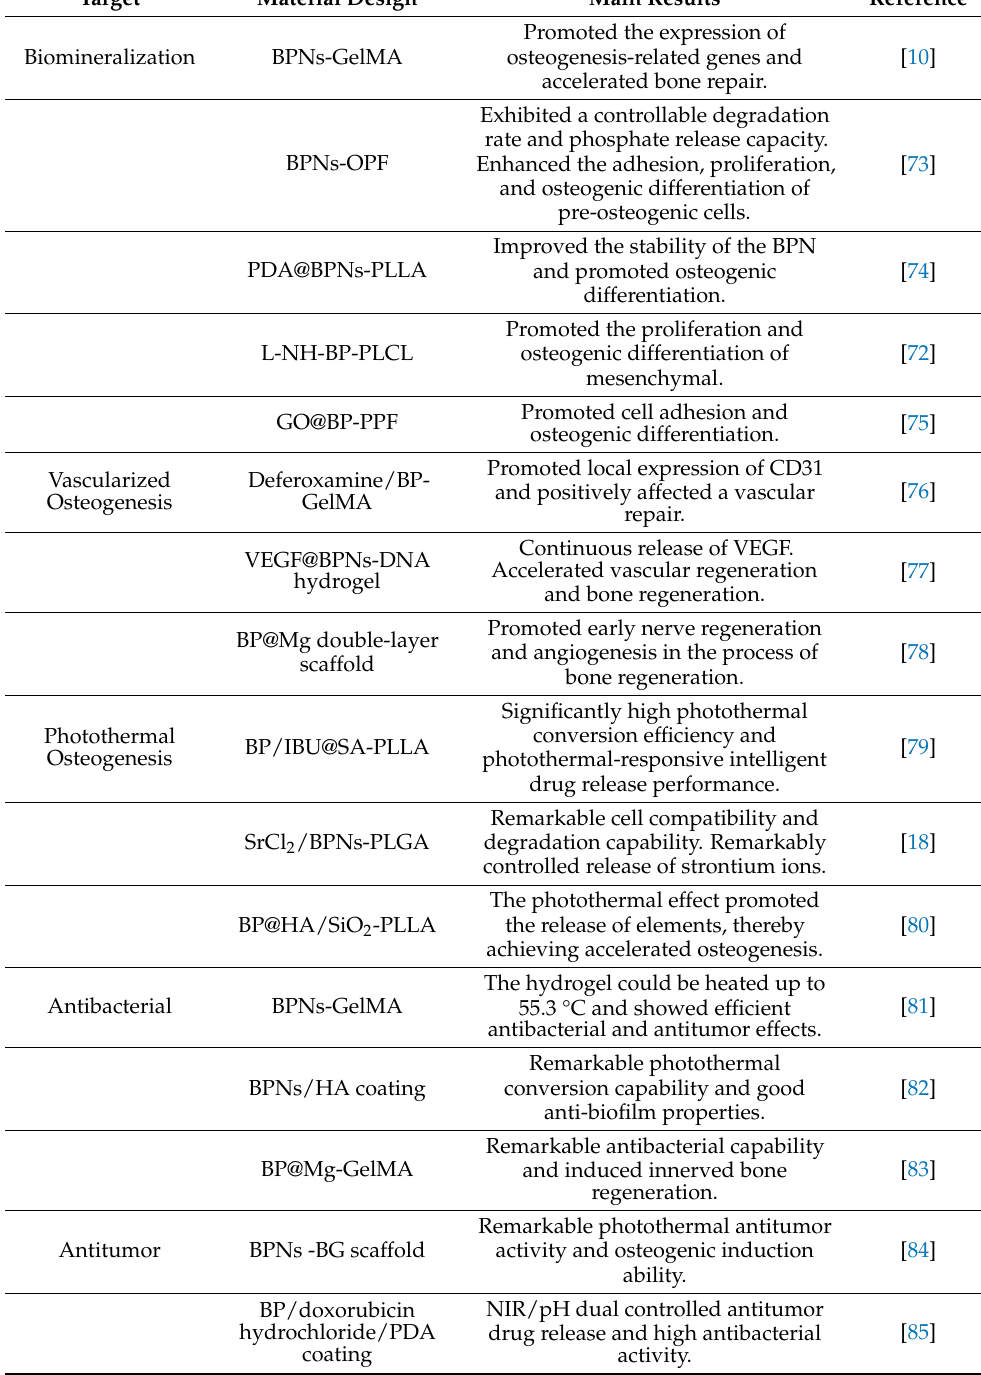
Table 1. Summary of the application of black phosphorus in bone tissue